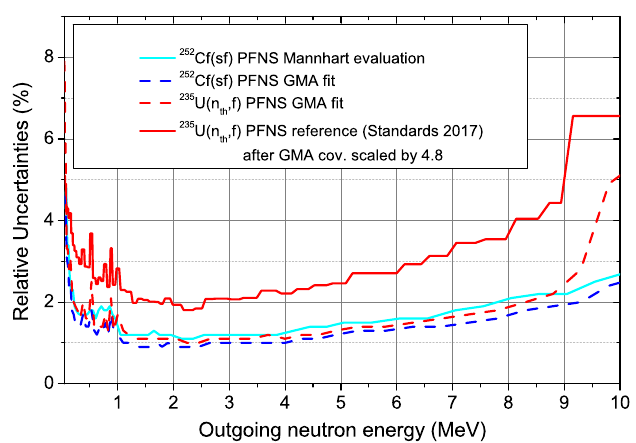
Fig. 6. Uncertainties of the 235 U( n th , f ) (bold red) and 252 Cf(sf) (cyan) PFNS evaluations are compared with the corresponding ones obtained in the GMA fi t (dashed